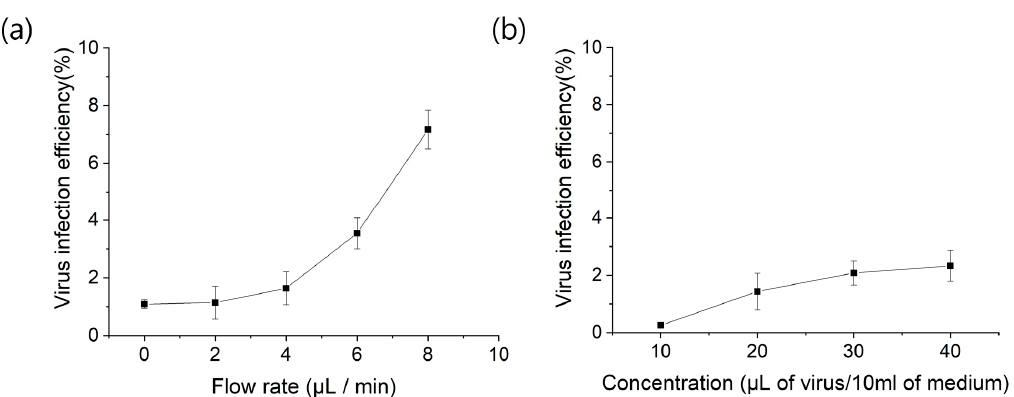
Figure 8. Virus infection efficiency of NIH/3T3 cells depending on ( a ) flow rate and ( b ) virus concentration. Dimensions of microchannel: 500 μ m (W) × 126 mm (L) × 150 μ m (H).